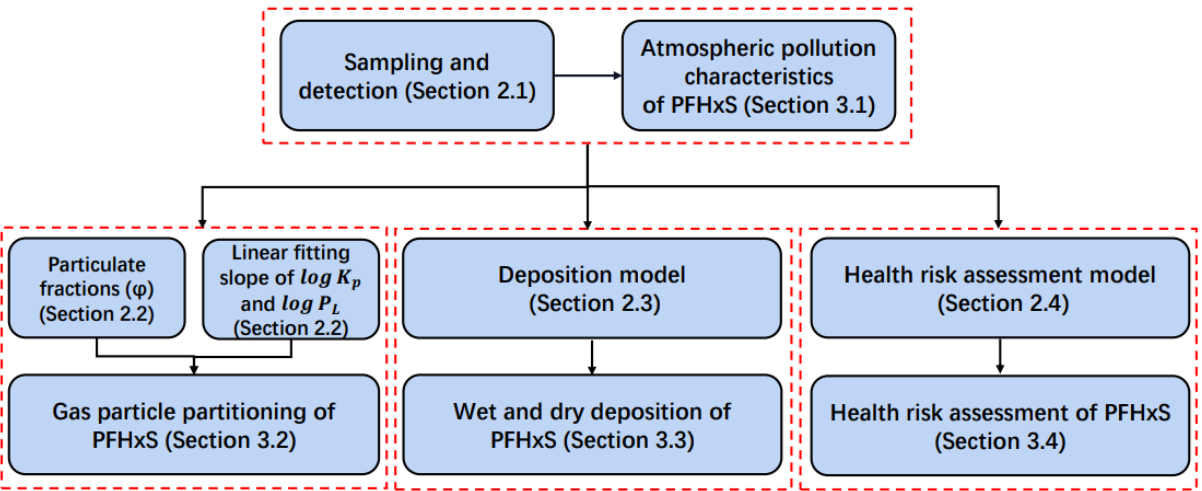
Figure 1. The methodology chart of this